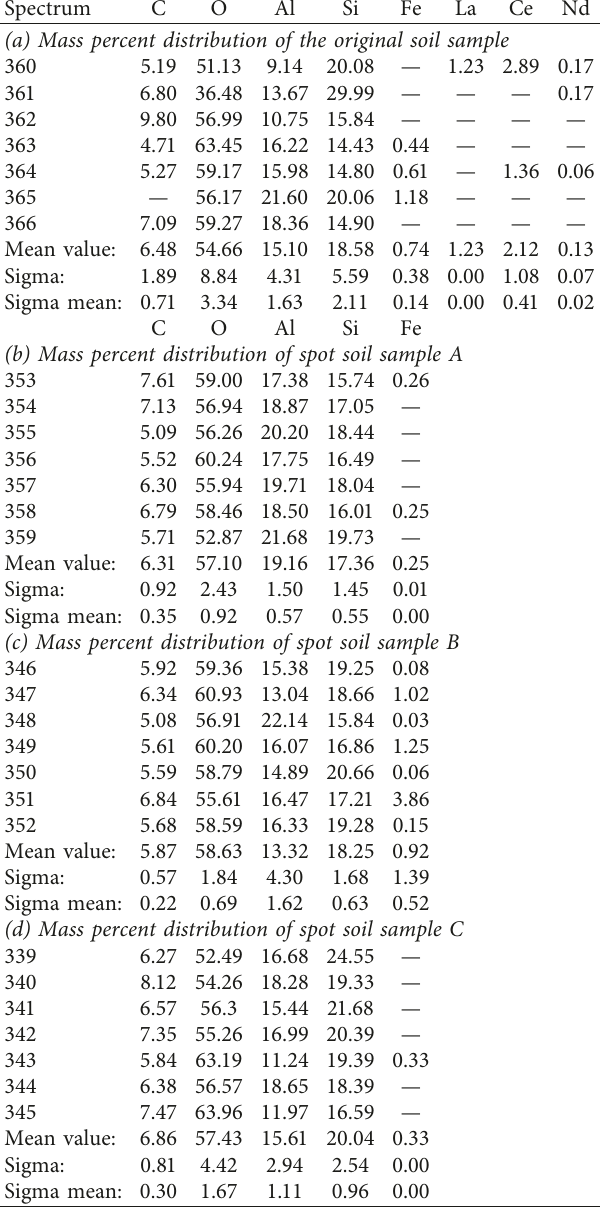
Table 2: Elemental mass percent distribution at each measuring